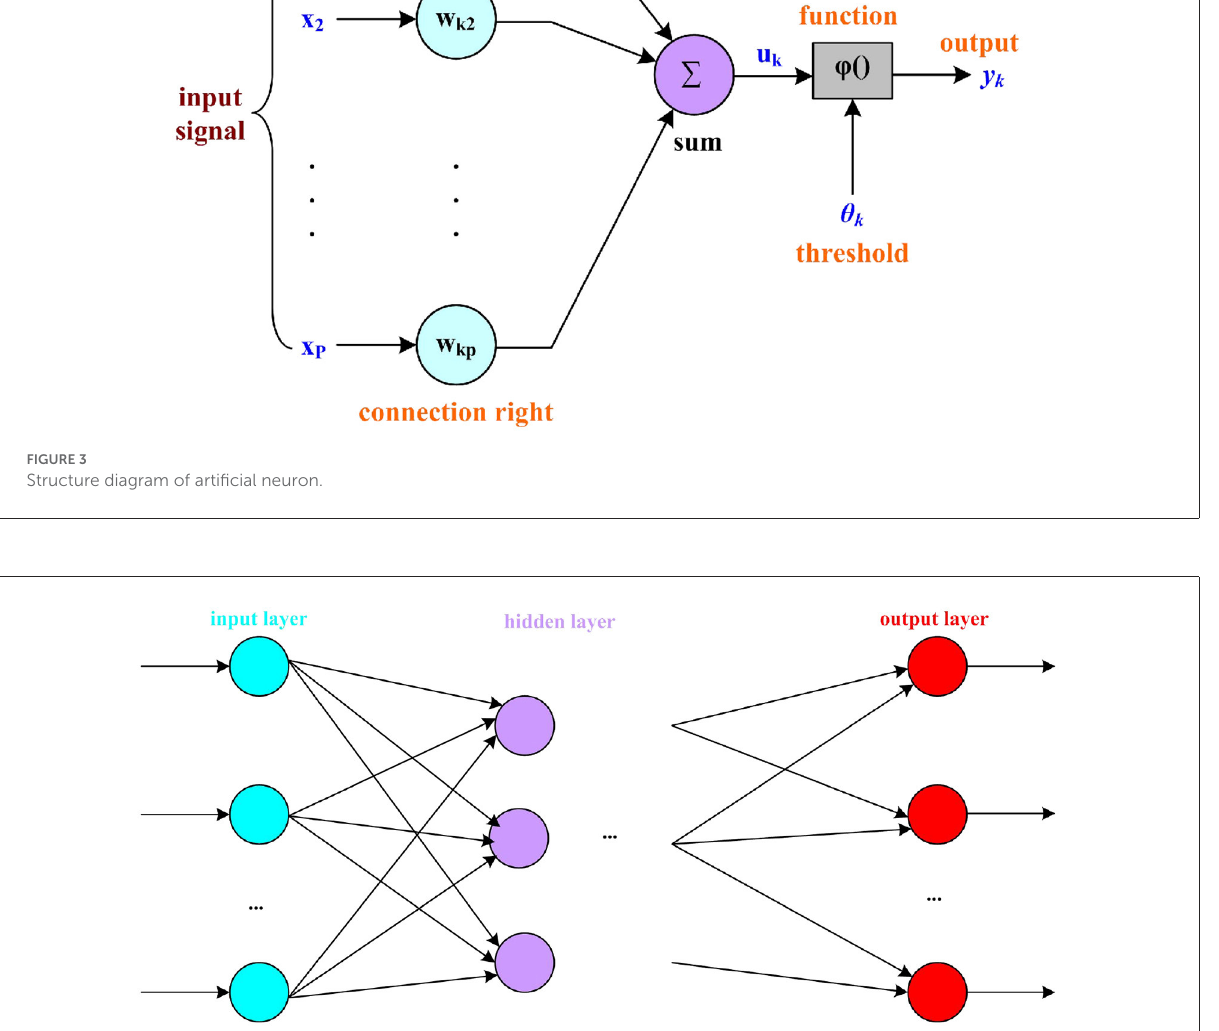
FIGURE4 Forward network topology